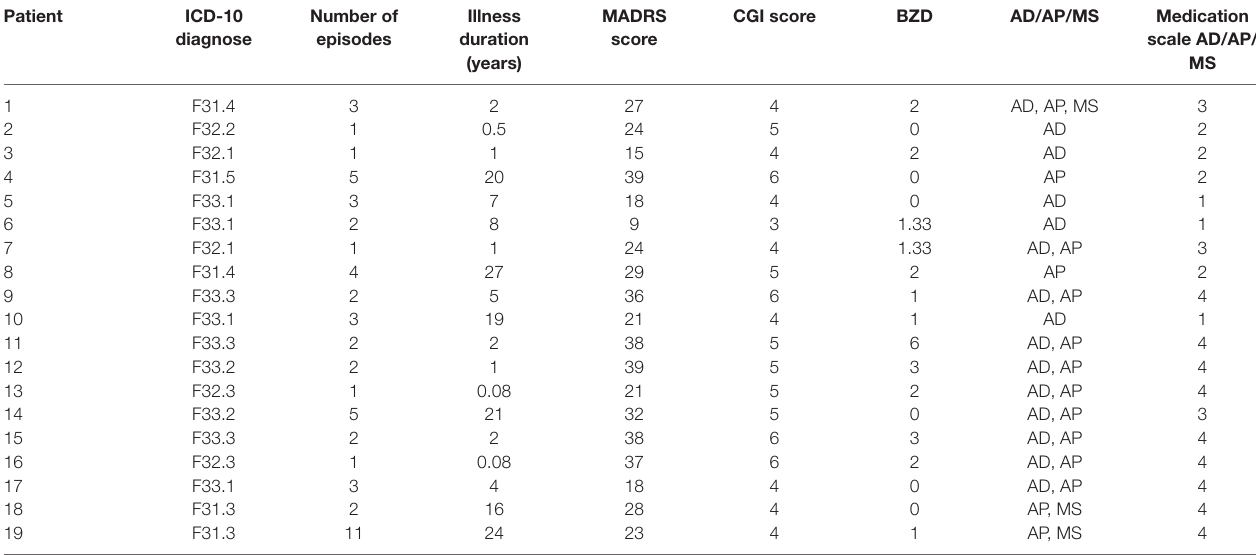
TABLE 1 | Patient